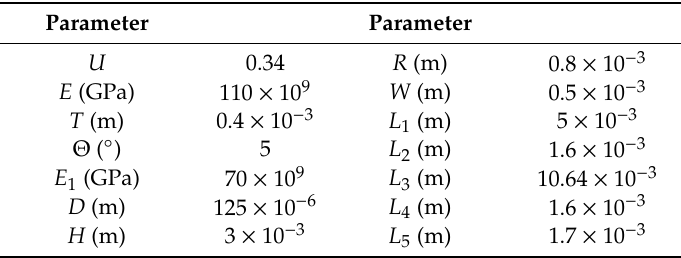
Table 1. The structural parameters of the